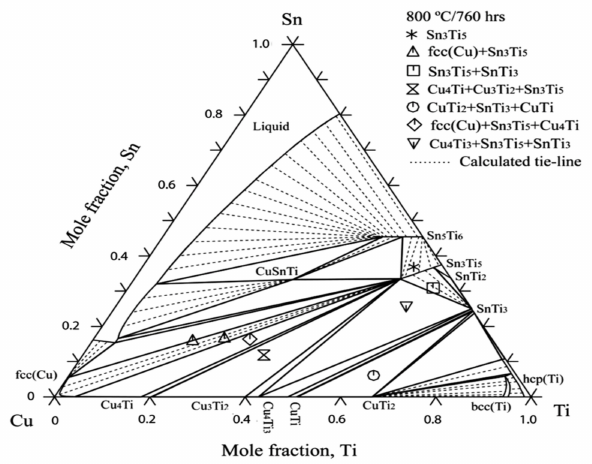
Figure 27. Ternary system of Cu-Sn-Ti ternary system at 800 ◦ C